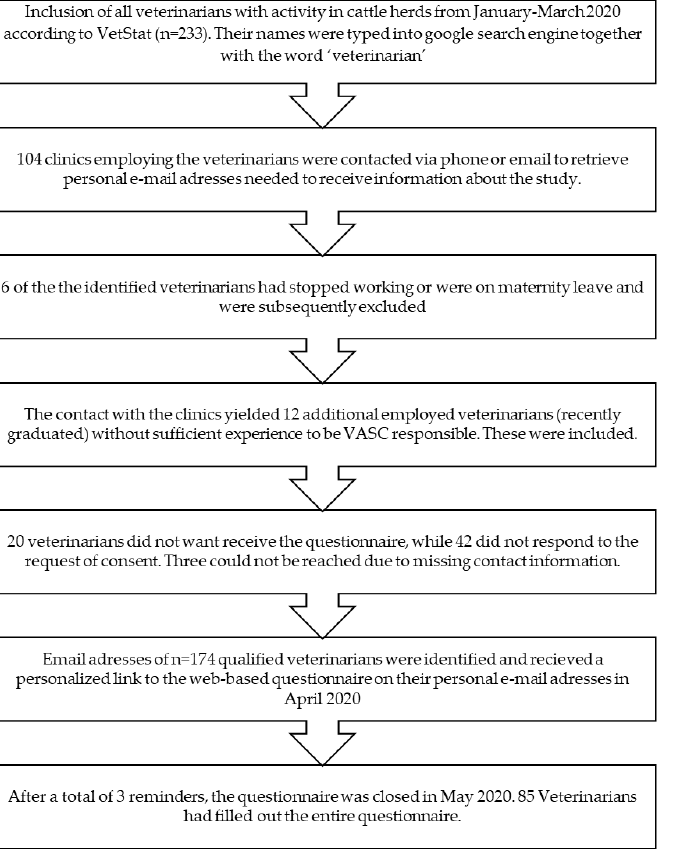
Figure 4. Flowchart of the selection process of the study population for the questionnaire survey of veterinarian treatment approach and antibiotic usage for mastitis by Danish cattle veterinarians.